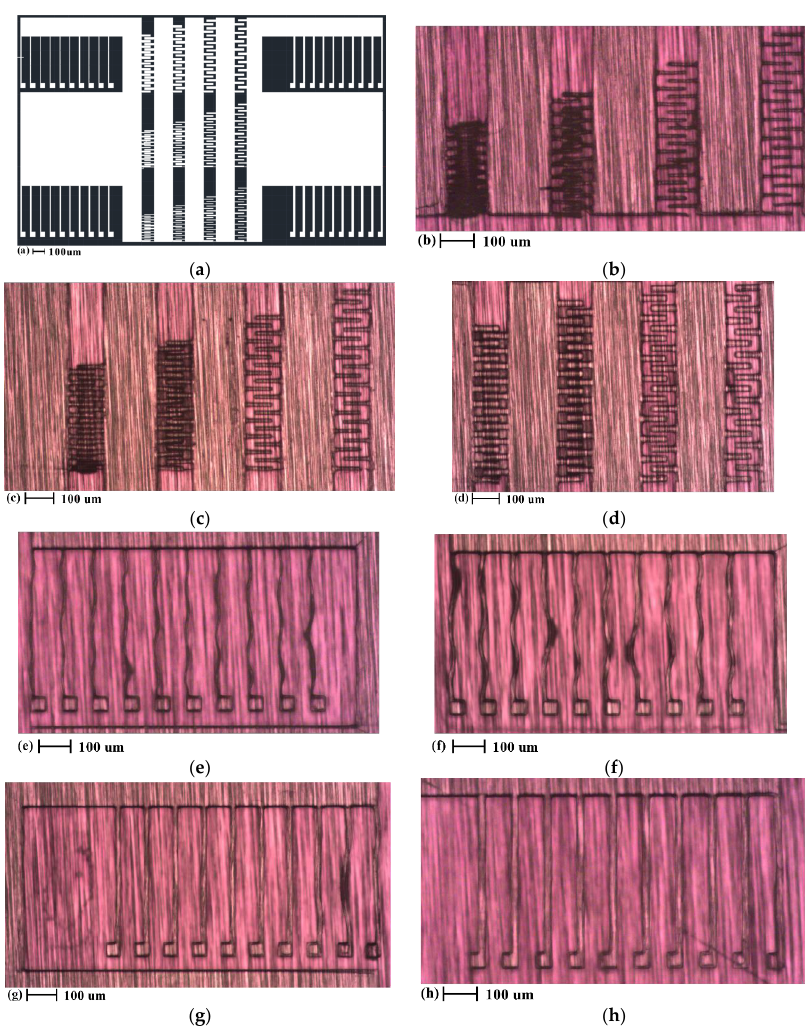
Figure 4. Mask design and the result of the SU-8 lithography calibration process. ( a ) The mask design for the calibration; ( b ) to ( d ): Representative lithography result for interdigitated plates with different plate width. ( b ): 5 µm, ( c ): 10 µm, ( d ): 20 µm. ( e ) to ( f ): Representative lithography result for beams with different width, ( e ): 5 µm, ( f ): 10 µm, ( g ): 15 µm, ( h ): 20 µm.